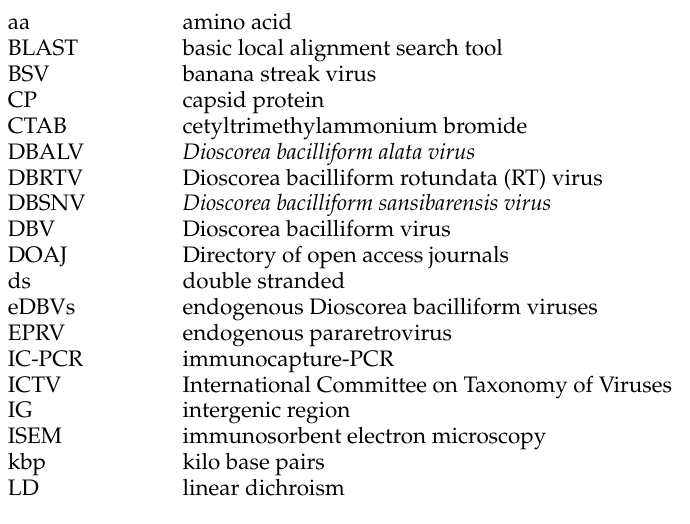
genome, Figure S4: Maximum Likelihood phylogenetic trees obtained from alignments of the complete genomic sequences and the nucleotide sequences of the ORF3 products of DBALV-[2ALa], DBALV-[2ALb], DBRTV1, Table S2: Comparison of genome features of eleven yam badnavirus